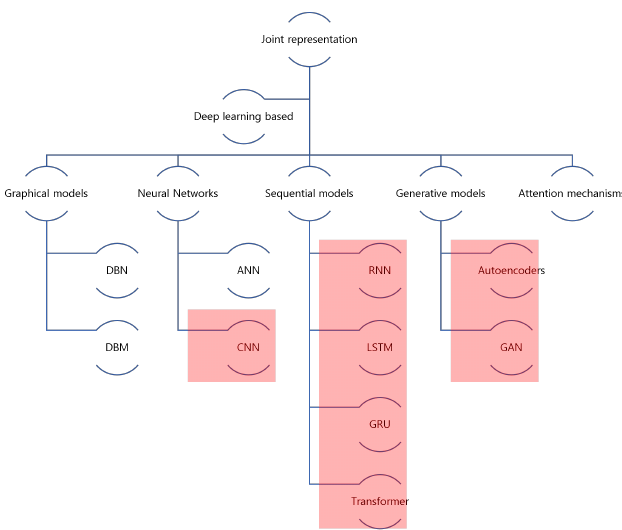
Figure 7. Hierarchy of